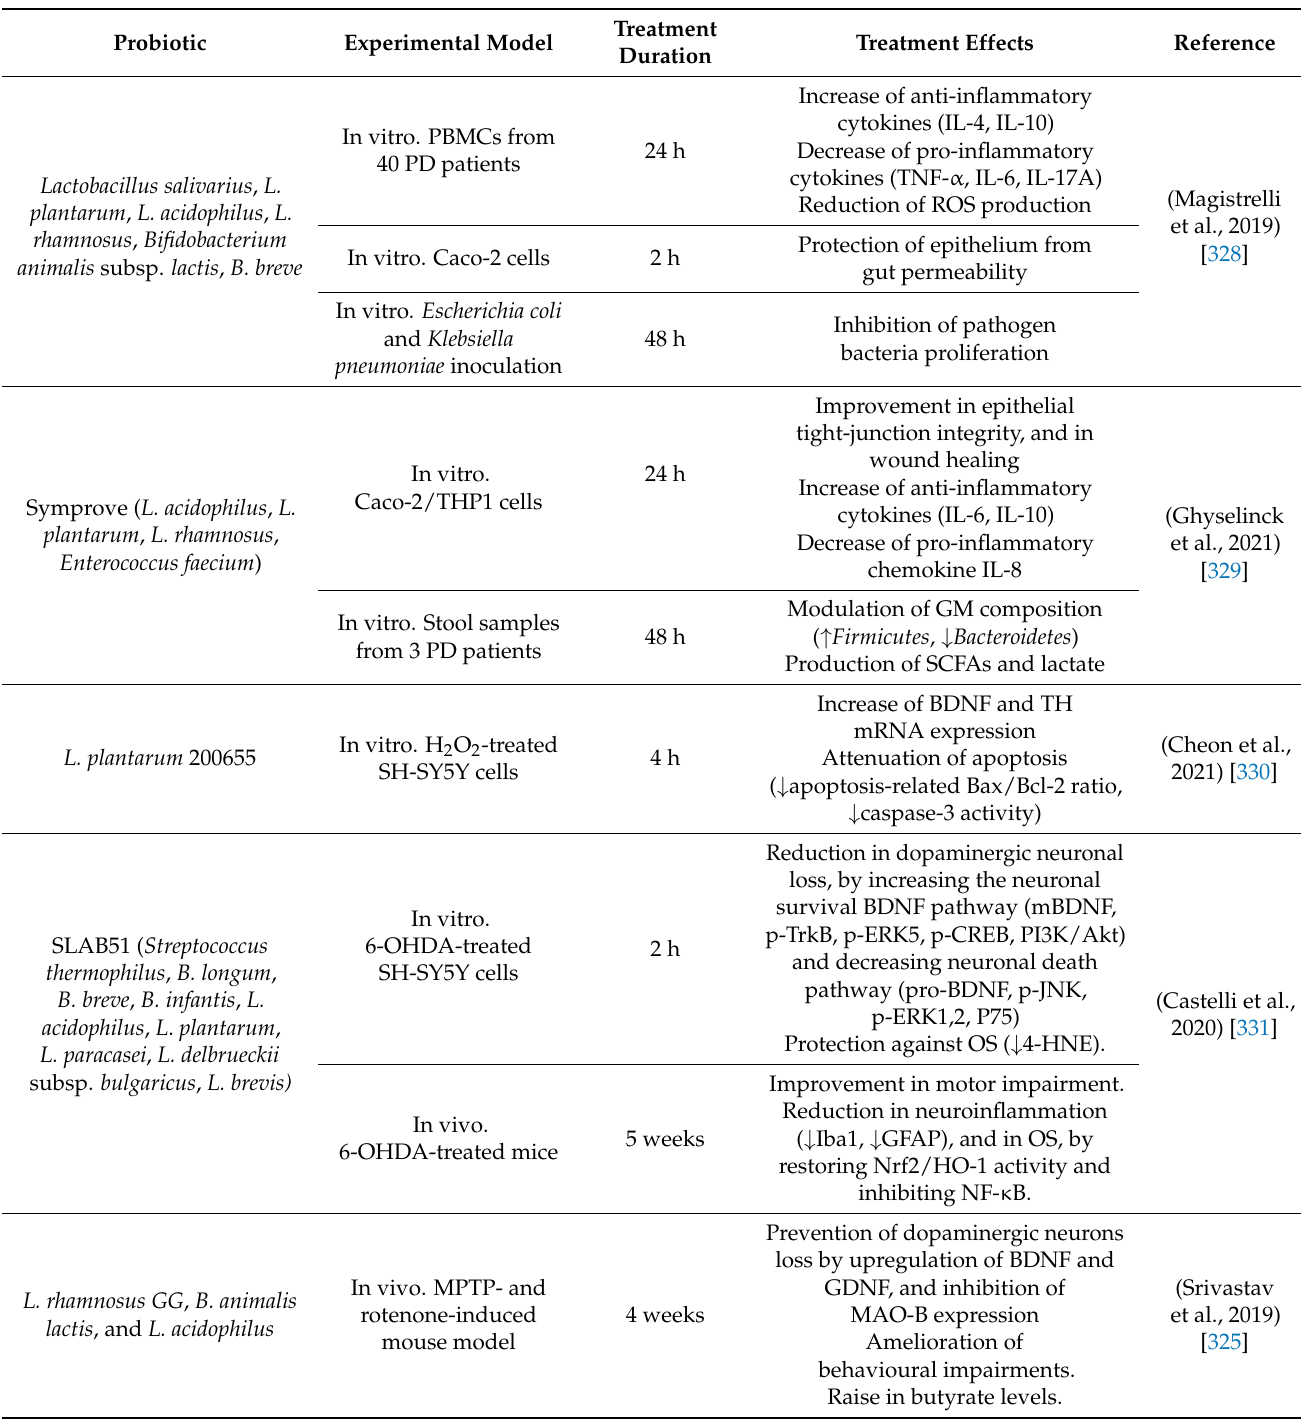
Table 1. The effects of probiotics treatment regarding in vitro and in vivo experimental